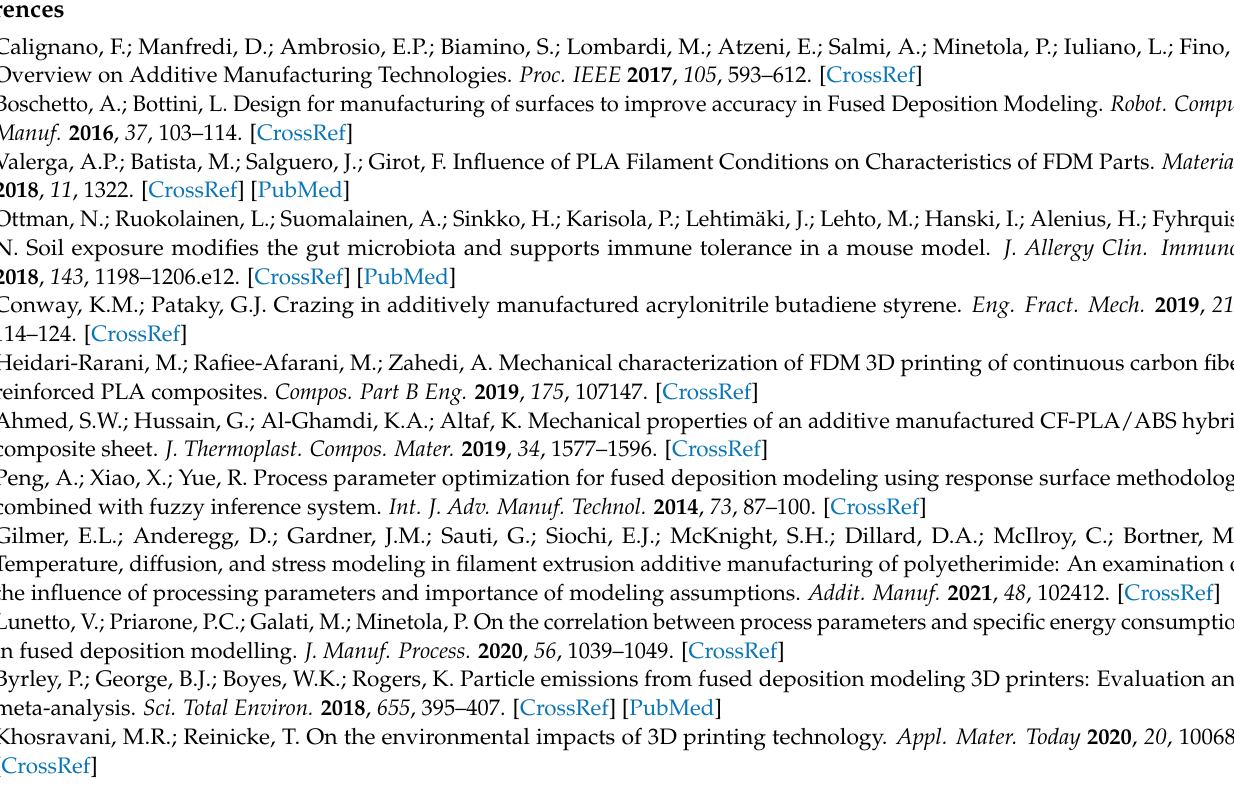
Table S5: Analysis of variance—CO 2 e; Table S6: Analysis of variance—material cost; Table S7: Analysis of variance—labor cost; Table S8: Analysis of variance—electricity